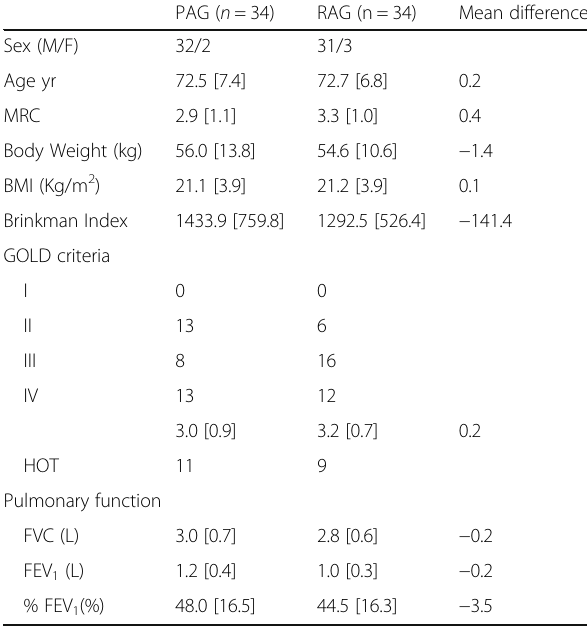
Table 1 Baseline subject